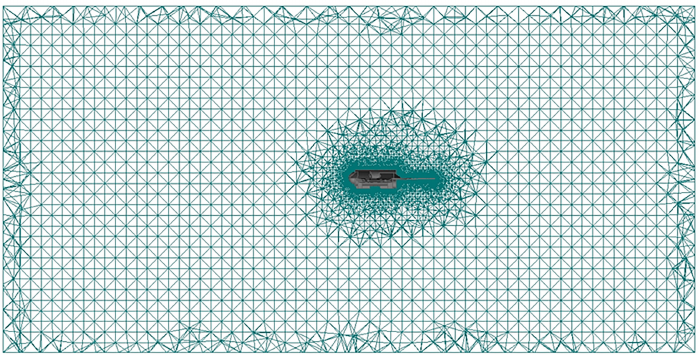
Figure 11. Mesh arrangement around the manta ray